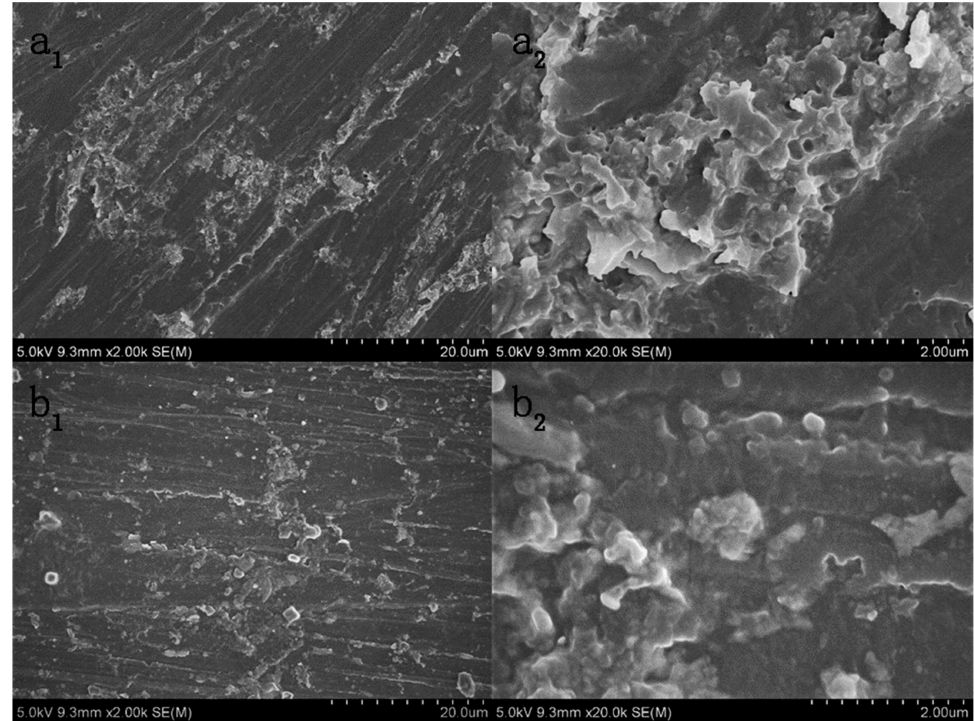
Figure 8. The morphologies of GO / EP ( a 1 , a 2 ) and TiO 2 –GO / EP ( b 1 , b 2